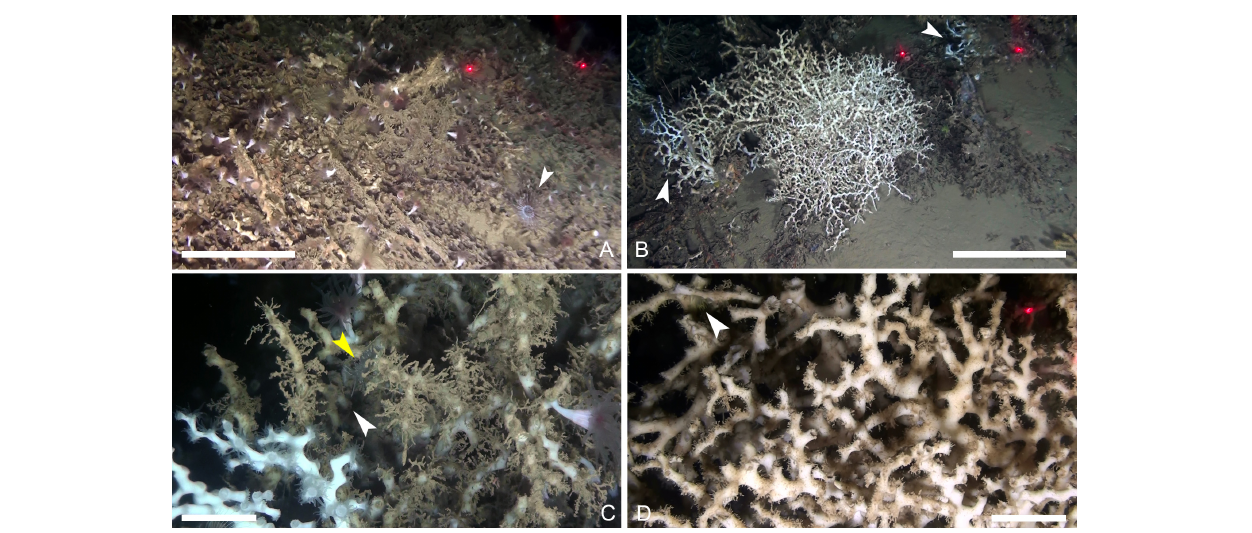
FIGURE 6 | Associated biodiversity (A) dense solitary coral growth Desmophyllum dianthus and Javania cailleti on dead coral frames at Site A, arrow pointed at cf. Pachycerianthus , bar = 20 cm; (B) isolated large Madrepora oculata colony with juvenile Desmophyllym pertusum (right side) colony (Site B), bar = 20 cm; (C) close-up on M. oculata frame (Site A), white arrow indicates the polychaete Eunice norvegica , an undetermined nudibranch is pointed at by a yellow arrow, bar = 5 cm; (D) close-up on a dead coral frame (Site B), white arrow indicates a grazing undetermined nudibranch, bar = 5